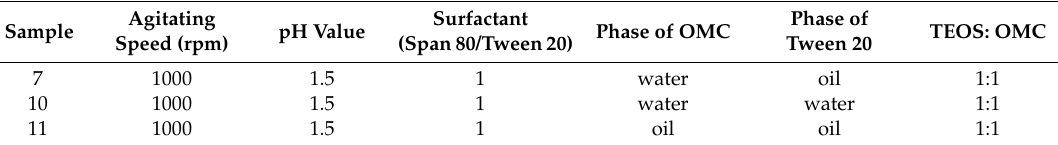
Table 2. The effect of OMC and surfactant added in different phase.